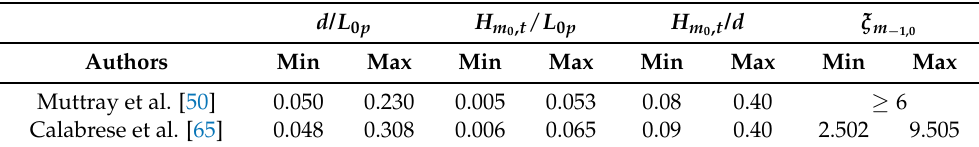
Table 3. Overview of the geometrical and wave parameters tested by Muttray et al. and Calabrese et al.